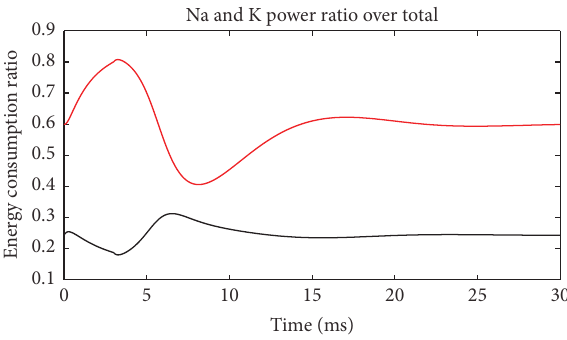
Figure 13: Energy consumption of each ion channel (subthreshold).